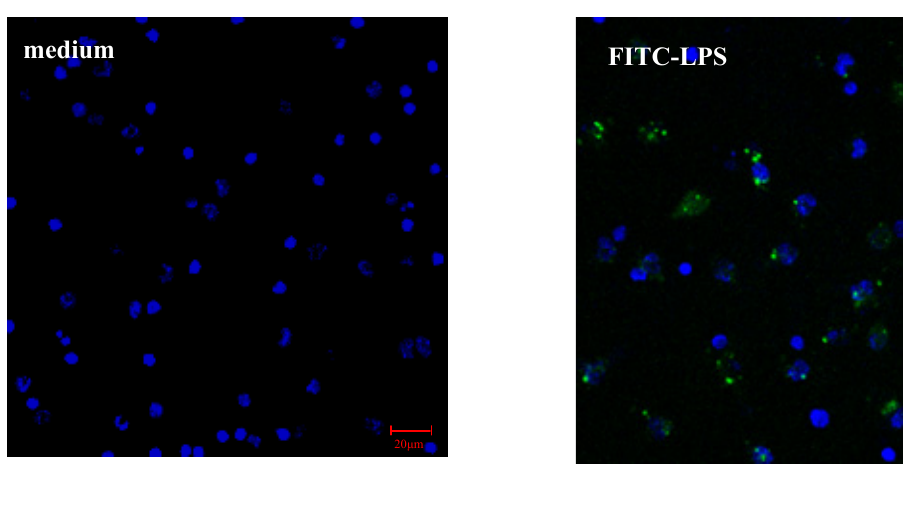
Figure 5. Effect of AS on LPS internalization by mouse peritoneal macrophages (400×). Mouse peritoneal macrophages (1.0 × 10 6 /mL, 500 μ L) grown on glass coverslips were pretreated with normal saline (NS) (medium); treated with FITC-LPS (500 ng/mL) for 30 min (FITC-LPS); pretreated with AS (10 μ g/mL) for 2 h and then treated with FITC-LPS (500 ng/mL) for 30 min (AS + FITC-LPS); pretreated with MDC (25 μ g/mL) and then treated with FITC-LPS (500 ng/mL) for 30 min (MDC + FITC-LPS); pretreated with MDC (25 μ g/mL) for 1 h and AS (10 μ g/mL) for 2 h, and then treated with FITC-LPS (500 ng/mL) for 30 min (MDC + AS + FITC-LPS). After washing and fixation, the nuclei were stained with 4',6-diamidino-2-phenylindole (DAPI, blue). The distribution of FITC-LPS as green color in cells was observed by laser confocal microscope. Images were captured and processed using the LSM Image Examiner software. ** p < 0.01 as compared to FITC-LPS, †† p < 0.01 as compared to MDC +